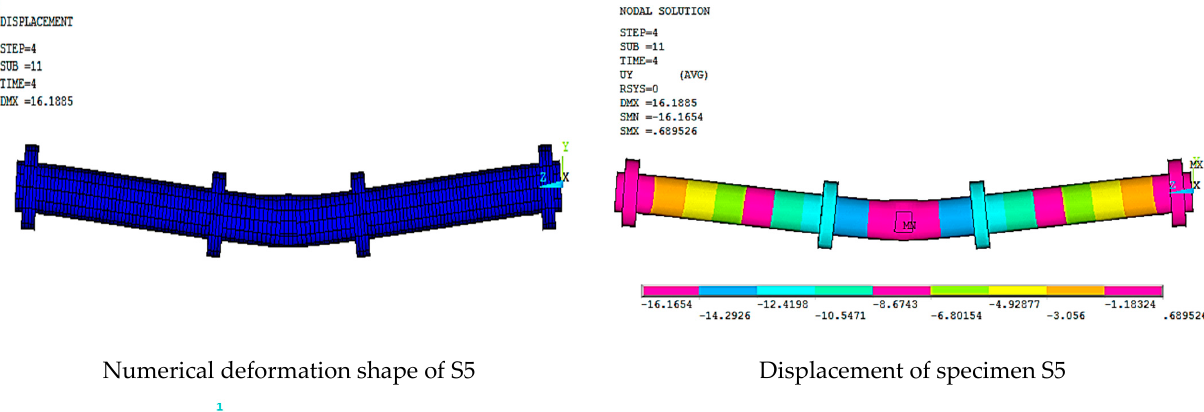
Figure 19. Numerical analysis of S4.